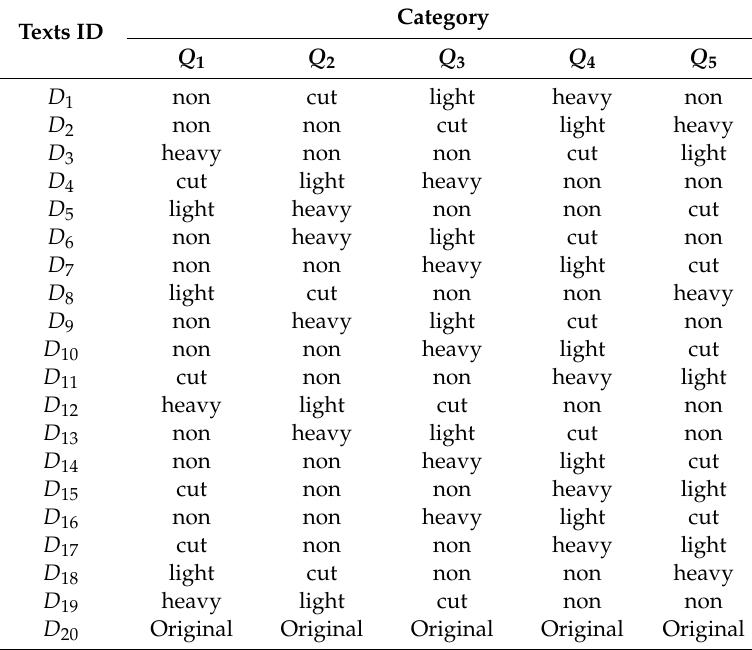
Table 5. The level of texts